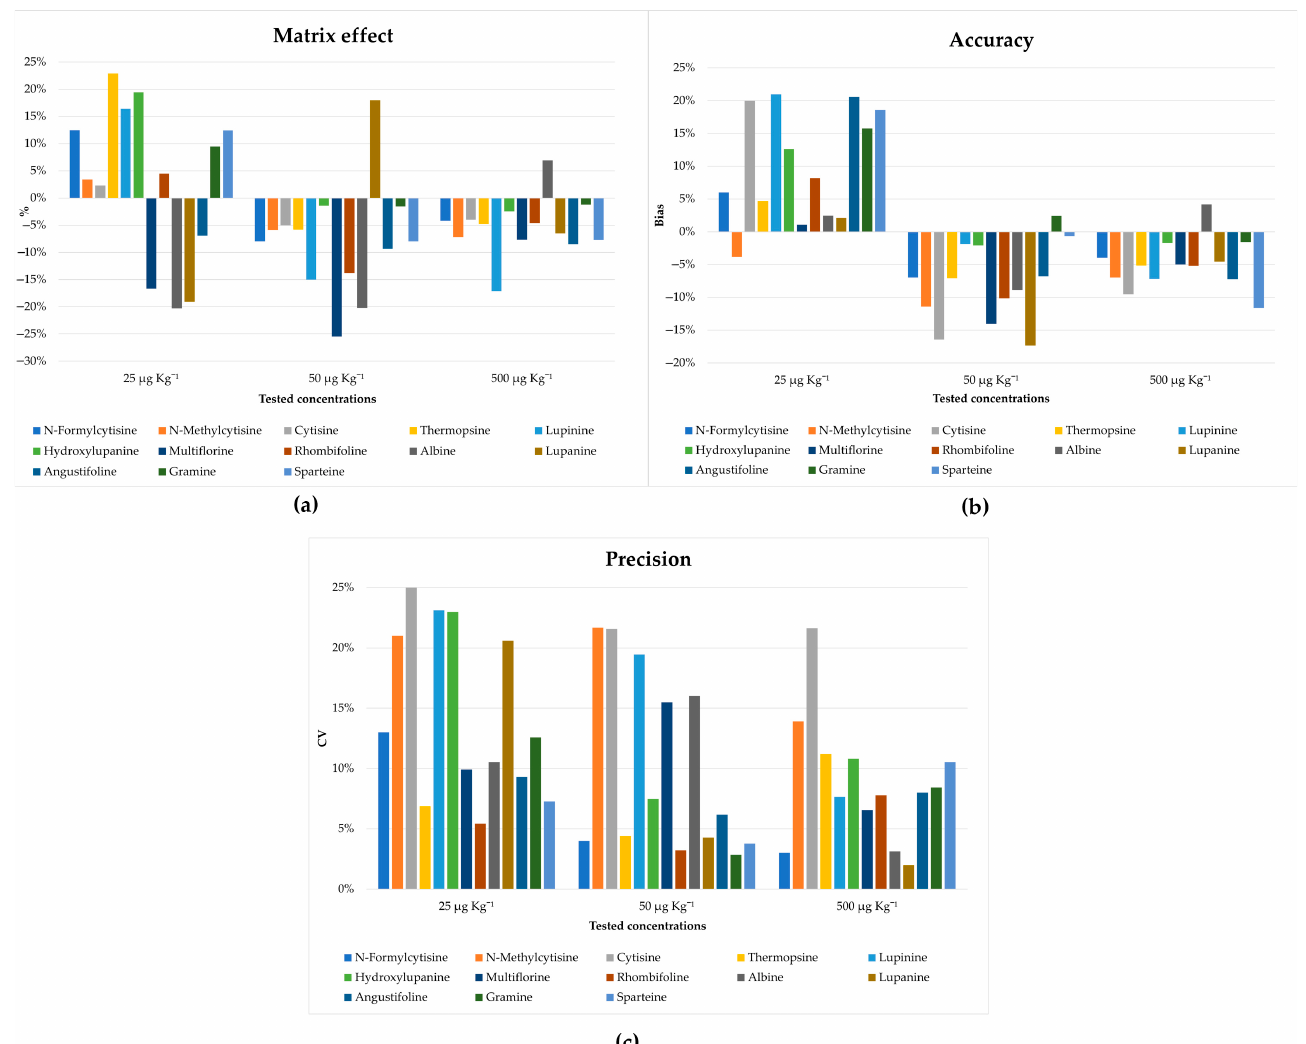
Figure 5. Validation parameters: ( a ) matrix effect reported as the suppression or enhancement of the signal, expressed as a percentage for all tested concentrations; ( b ) accuracy was reported as bias% for all tested concentrations; ( c ) precision was reported as CV for all tested concentrations.